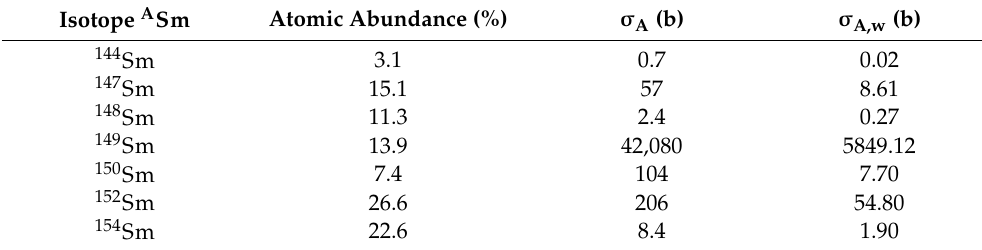
Figure 13. Shielding performance of Sm 2 O 3 -APTES/AFG-90H: ( a ) neutron permeability (I/I 0 ); ( b ) secondary γ dose.